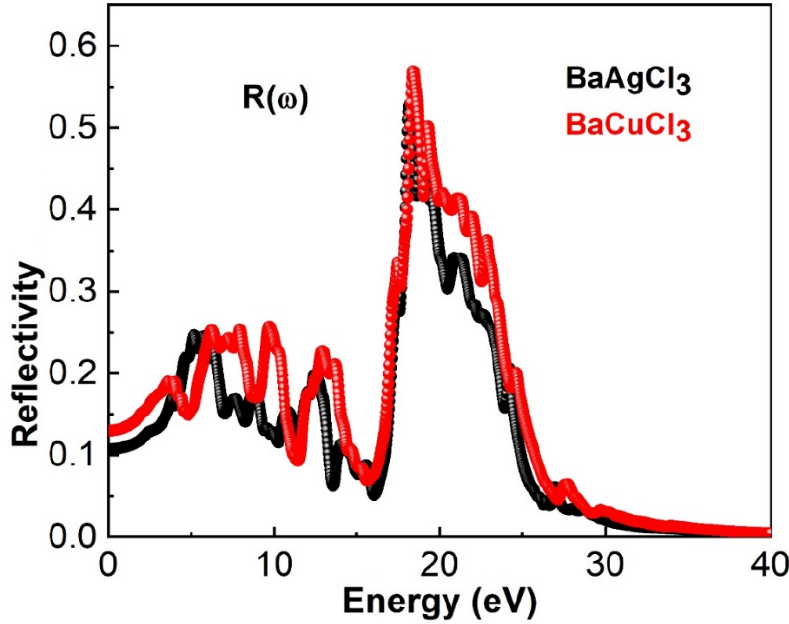
Figure 8. The optical reflectivity of ternary BaAgCl 3 and BaCuCl 3 chloroperovskites compounds. The value of reflectivity at zero energy is 0.106 and 0.12 for BaAgCl 3 and BaCuCl 3 , respectively. The materials are more reflective in the energy range of 16 eV to 25 eV. The highest peak is found at 0.524 at 18.17 eV for BaAgCl 3 while for BaCuCl 3 the highest peak is 0.566 at 18.4 eV. 6.3. Absorption Coefficient A material’s ability to transmit light of a specific wavelength for a certain distance before it is absorbed depends on its absorption coefficient. Using the following expression, the I ( ω ) can be determined: I ( ω ) = (cid:2872)(cid:3095)(cid:3038) (cid:3090)